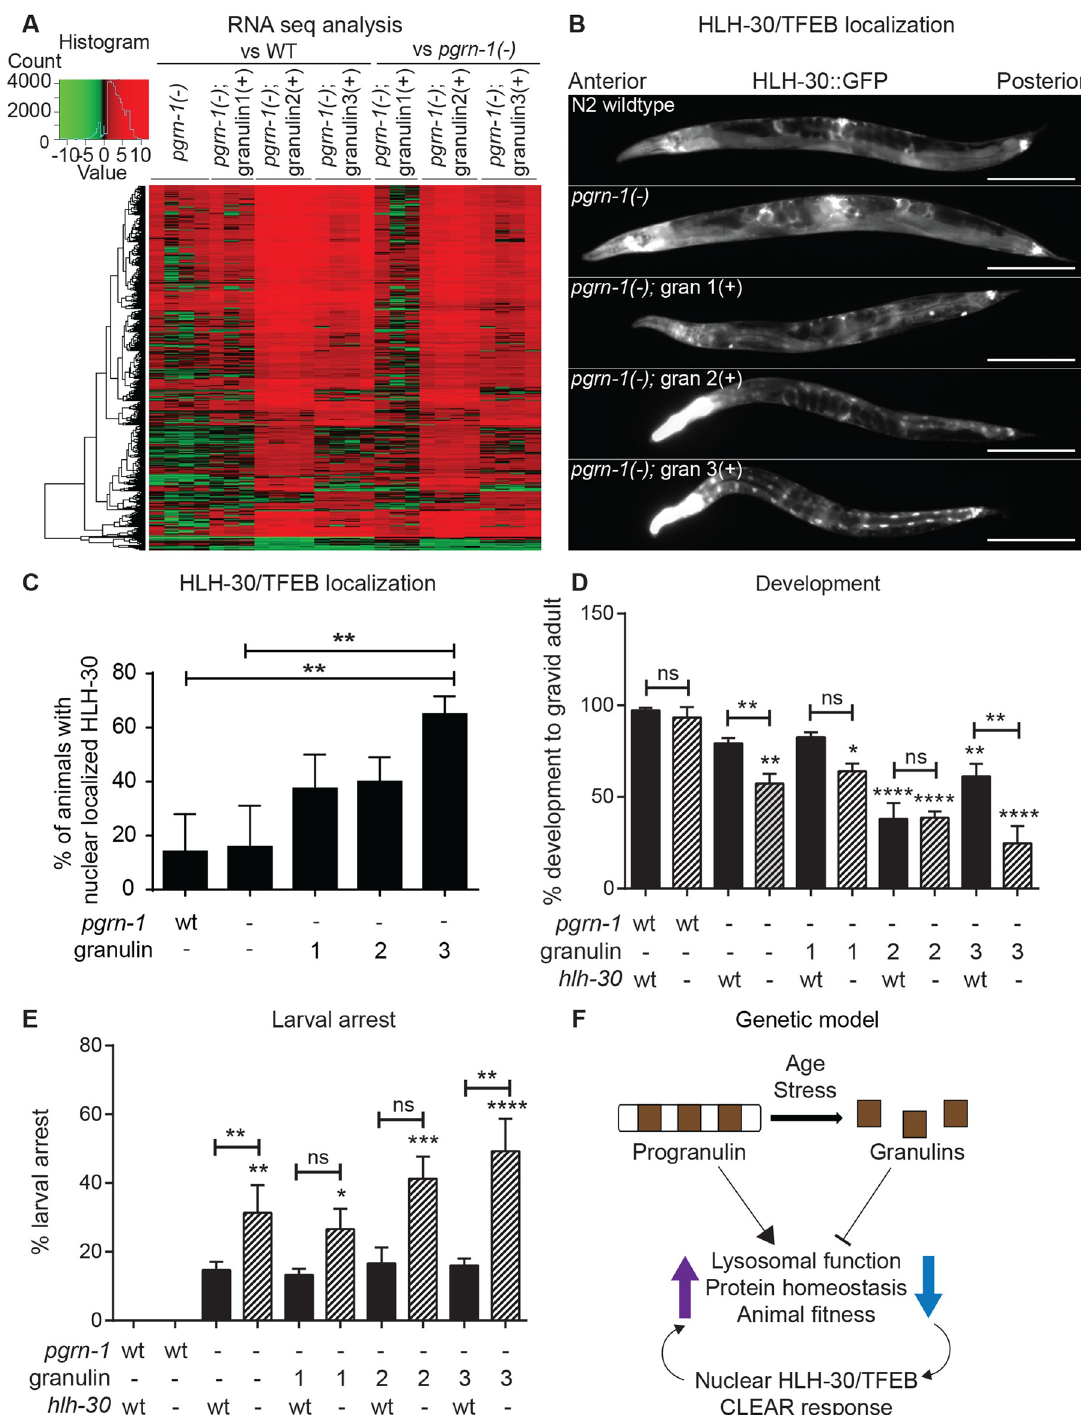
Fig 6. Granulins activate the lysosomal CLEAR response and induce nuclear localization of HLH-30/TFEB. ( A ) Heat map showing the fold-changes of gene expression in comparisons of day 1 adult animals as indicated. Data from four independent biological replicates are shown (except for granulin 1 where one sample was excluded as a quality control outlier). Significance cut-off was a false discovery rate (FDR) of P < 0.05 (up-regulated = red, down-regulated = green). Number of HLH-30/TFEB binding sites identified/total number of DEGs: pgrn-1(-) vs wt: 67/233, pgrn-1(-) ; granulin 1(+) vs wt: 18/179, pgrn-1(-) ; granulin 2(+) vs wt: 408/4050, pgrn-1(-) ; granulin 3(+) vs wt: 1136/2560. See S1–S5 Tables for the complete gene lists. ( B ) Representative images of wild-type, pgrn-1(-) and pgrn-1(-); granulin 3(+)